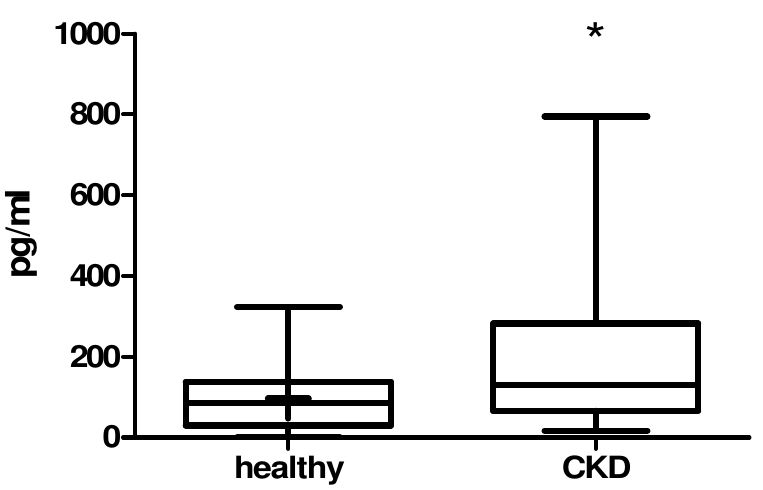
Figure 1. Comparison of FGF 23 between healthy and CKD cats. Data are expressed as median ± SD. The data were analyzed using the Mann–Whitney U test. The box indicates the lower and upper quartile, and the central line is the median. The points at the ends of the whiskers are the 2.5 and 97.5% values. The box plot shows the serum level of FGF 23 in healthy and CKD cats. The FGF 23 level of CKD animals is significantly higher than in healthy controls. Significance vs. healthy ani- mals is given as * p < 0.05. Table 1. Results of laboratory analysis of biochemical parameters.